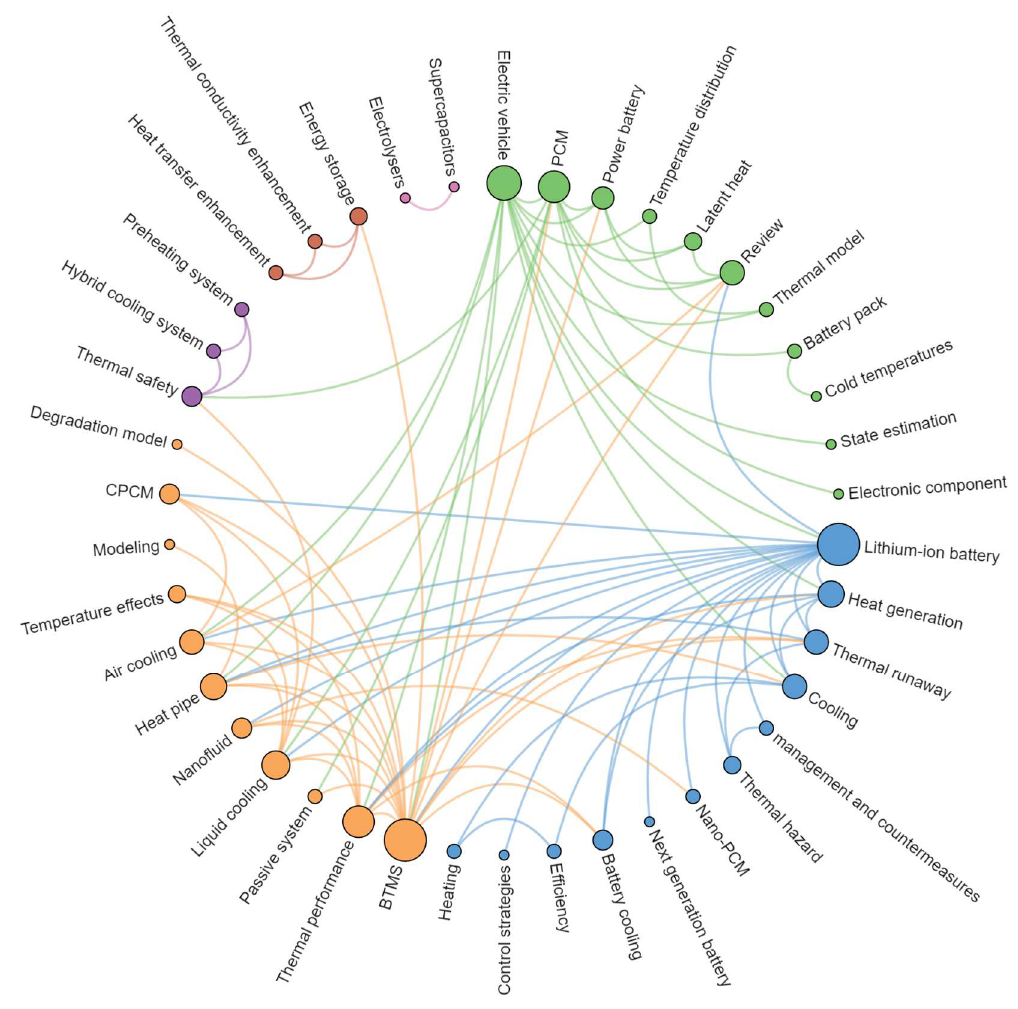
Figure 5. Keywords co-occurrence network of the review.